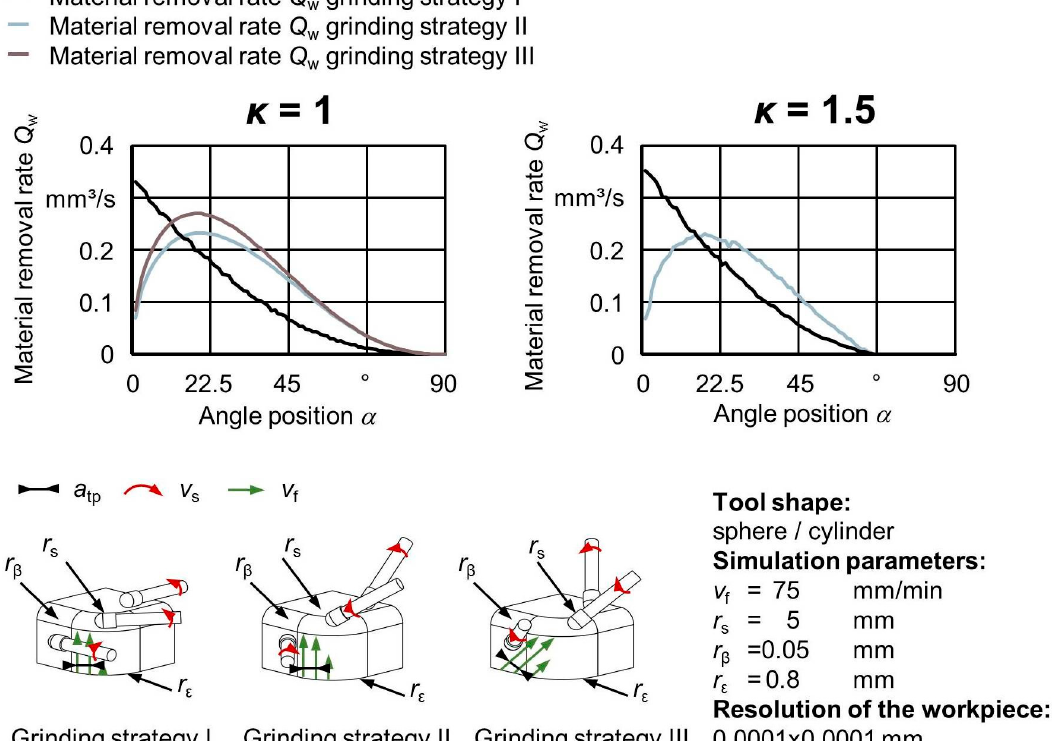
Figure 8. Simulation results for different form grinding strategies.